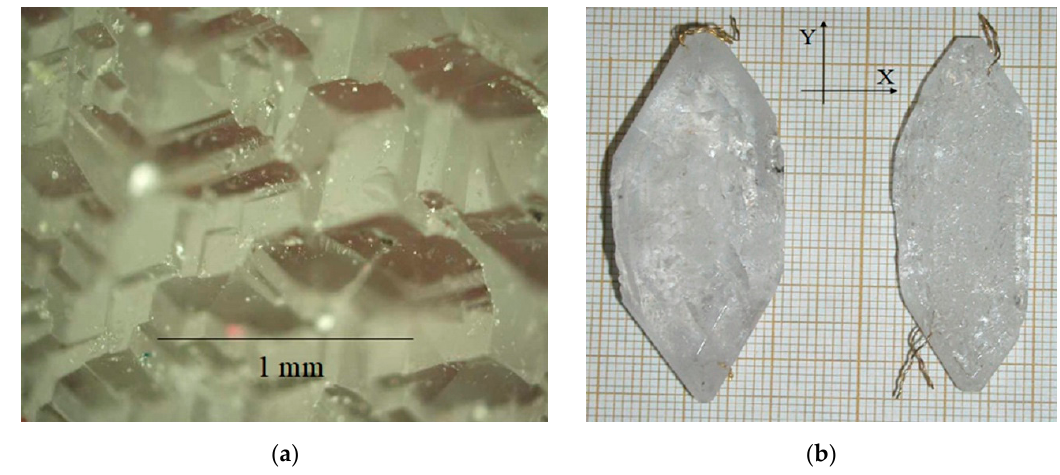
Figure 5. ( a ) Poly ‐ head face of basal pinacoid c{0001}, formed by trigonal rhombohedral pyramids π’ { 011(cid:3364)2 } or z{ 011(cid:3364)1 }, gradients above 15–20 °C; ( b ) GaPO 4 crystal grown on ZY seed plate.